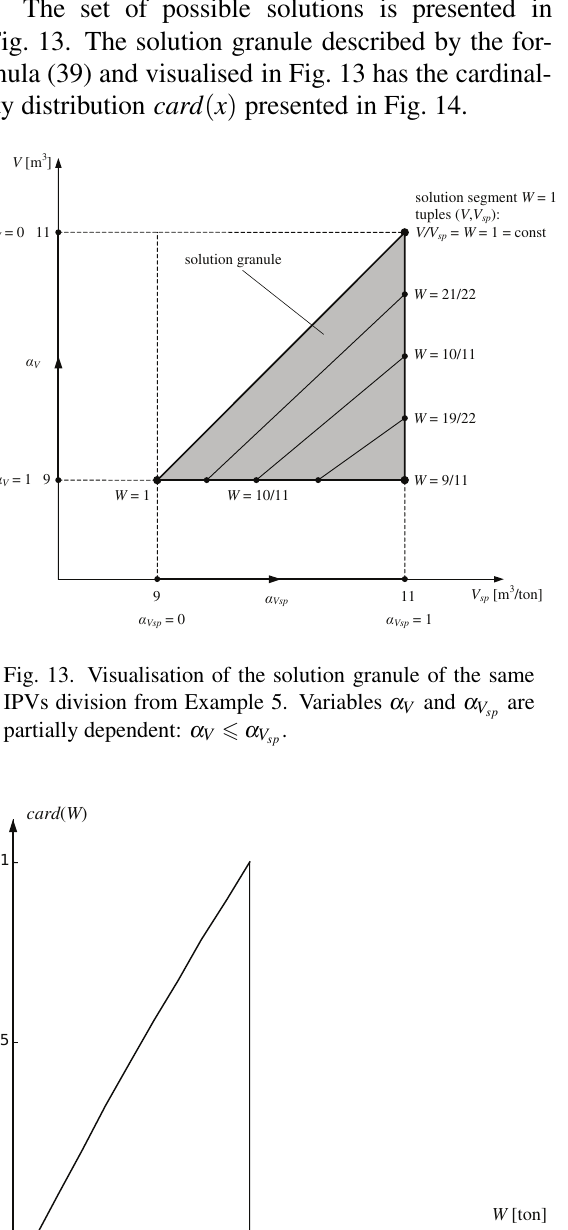
Fig. 14. Cardinality distribution card ( W ) of the solution of the same IPVs division from Example 5 as representation of the full solution